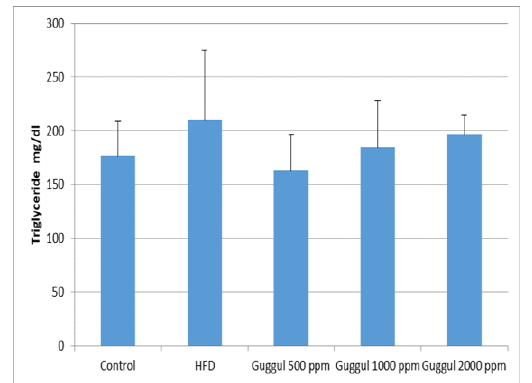
Figure( 3) Effects of guggulsterone on TG level of mice models with high-fat diet induced NAFLD.